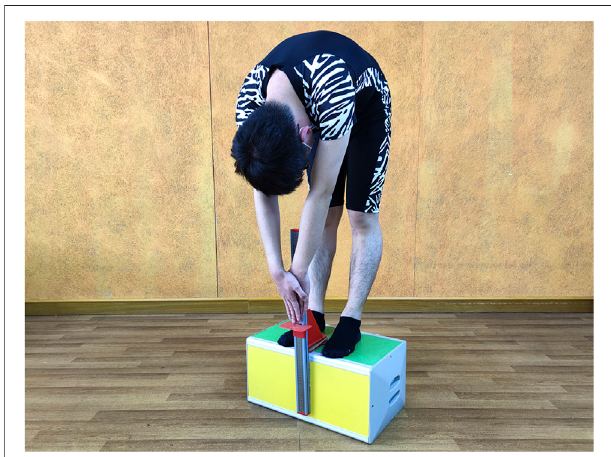
FIGURE 4 | Toe touch